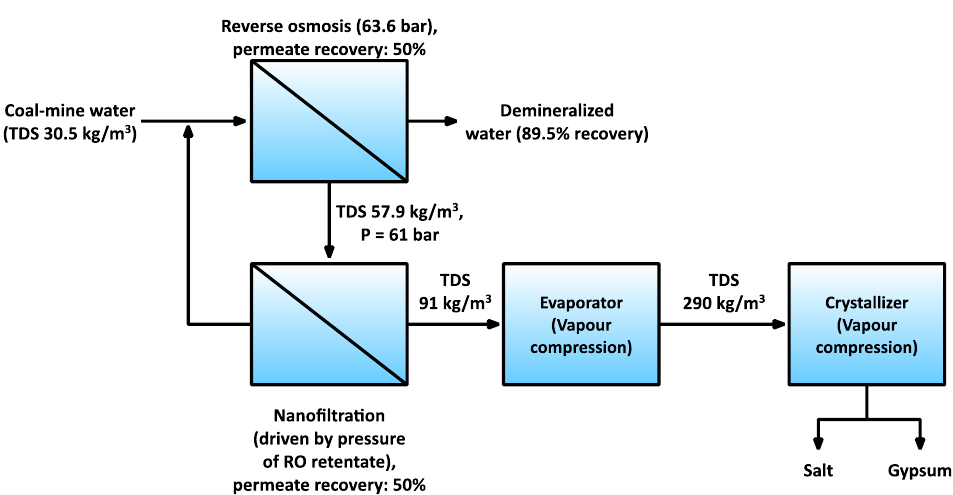
Figure 3. An overview of the proposed RO–NF system [30].